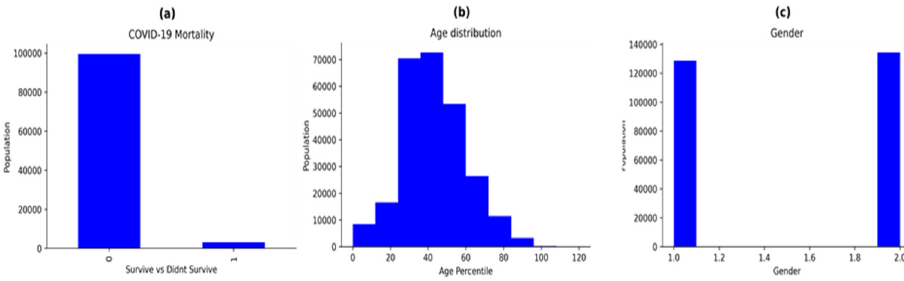
Figure 1. Statistical distribution of